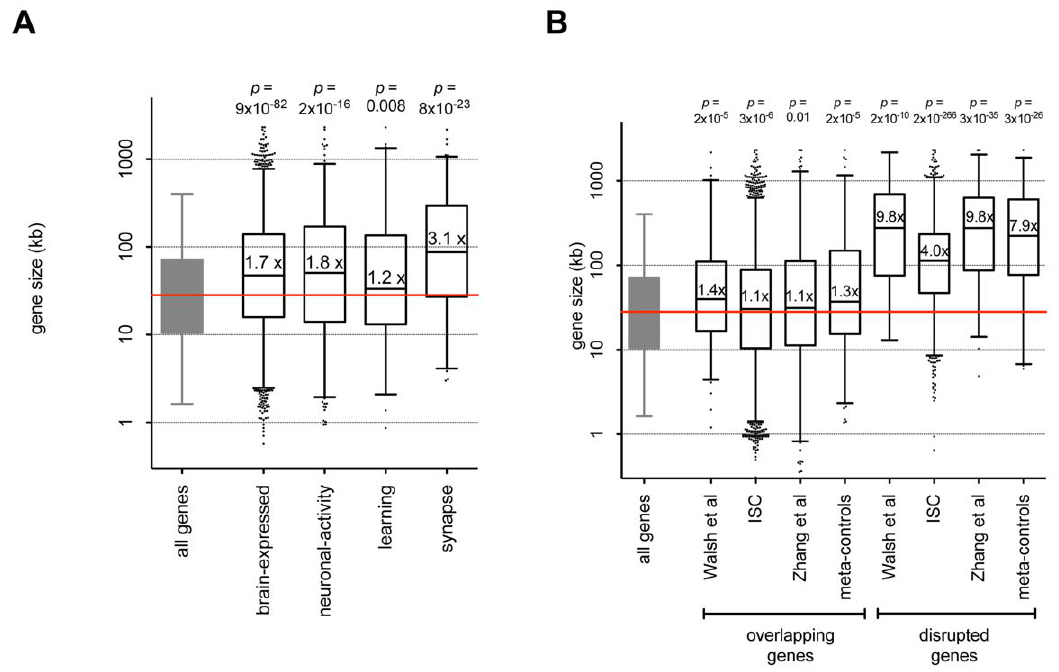
Figure 3. Genes with brain function and genes impacted by CNVs are large. A. Brain-expressed, neuronal-activity, learning, and synapse gene sets consist of large genes. For each gene set we plot the length of each gene, relative to the median length of human genes (28.2 kb). Median gene length is labeled and represented by a horizontal line. Box indicates the range of gene lengths (2.5%–97.5%). Outliers are plotted as dark points outside the box. For each gene set we compared the length of genes within the set and outside the set with a two-tailed rank-sum p -value. B. Genes overlapping and disrupted by rare CNVs are large. For each data set we plot the length of genes overlapping (left) and disrupted by (right) rare CNVs, relative to the median length of human genes (28.2 kb). Median gene length is labeled and represented by a horizontal line. Box indicates the range of gene lengths (2.5%–97.5%). Outliers are plotted as dark points outside the box. For each set we compared the length of genes affected and not affected by CNVs with a two-tailed rank-sum p -value. To allow for consistent comparisons, we restricted meta-control events to those . 100 kb.